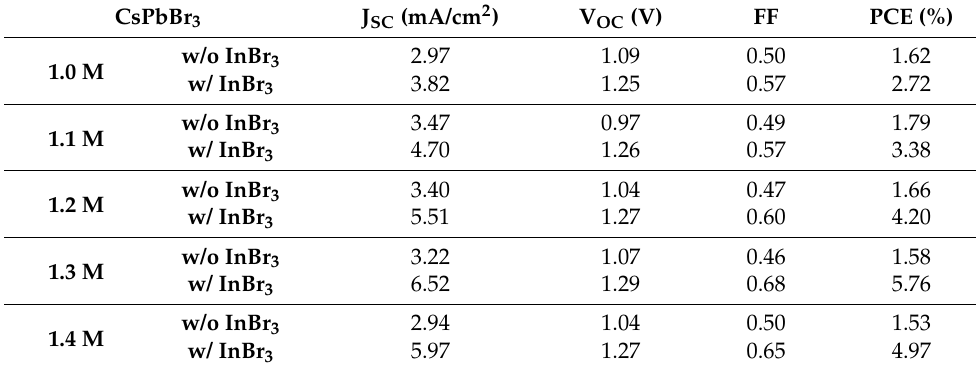
Figure 4. ( a ) Cross-sectional SEM image of the InBr 3 :CsPbBr 3 device; ( b – f ) J–V characteristics and ( g ) EQE spectra and integrated photocurrent densities for the InBr 3 :CsPbBr 3 devices synthesized with different PbBr 2 concentrations. Table 1. Key J-V parameters of the corresponding CsPbBr 3 solar cells.